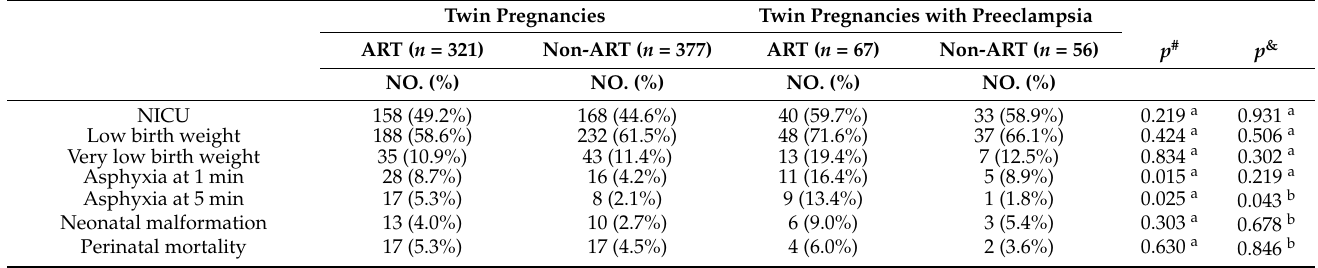
Table 5. The neonatal outcomes of twin pregnancies with preeclampsia and their association with